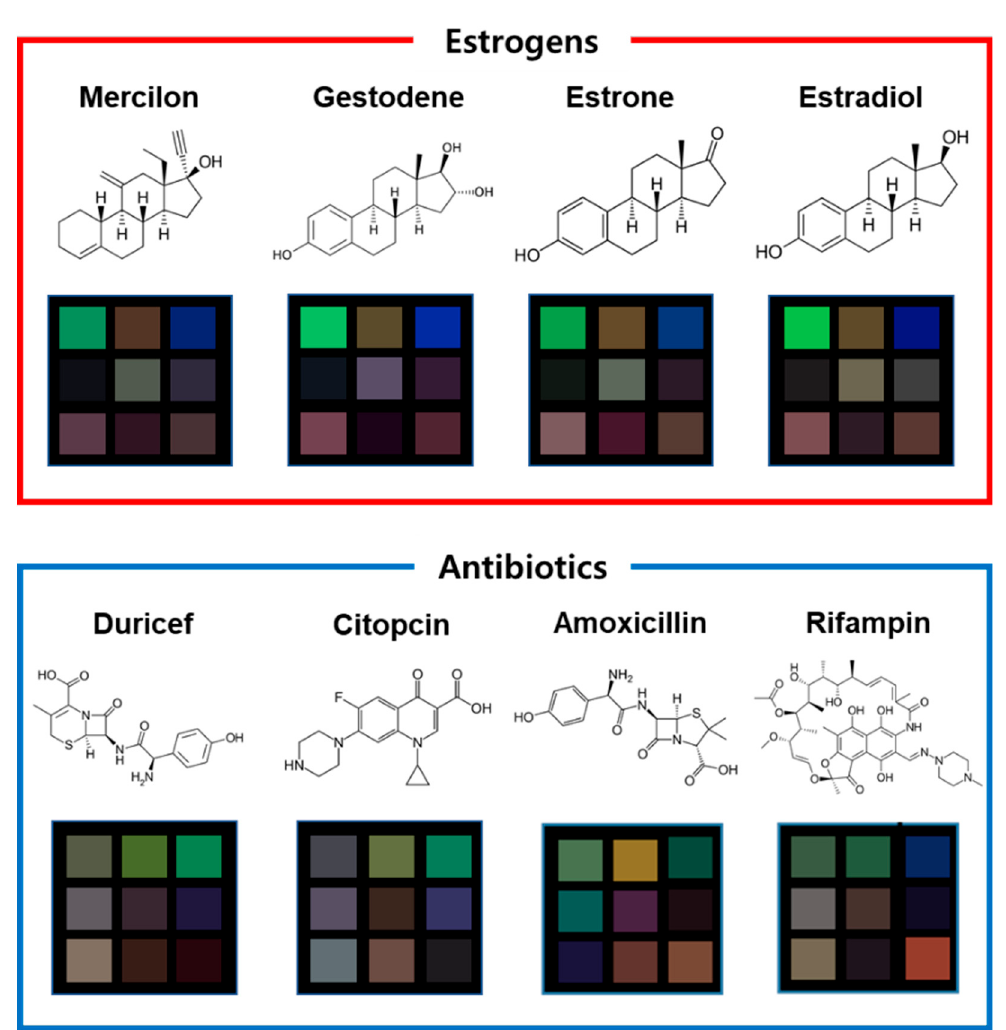
Figure 2. Image of the colorimetric sensor array chip after exposure to medical chemicals. The color pixels represent the mean value of the variation of the RGB values (in 8 bit) as a function of the M13 bacteriophage bundle’s structural change.